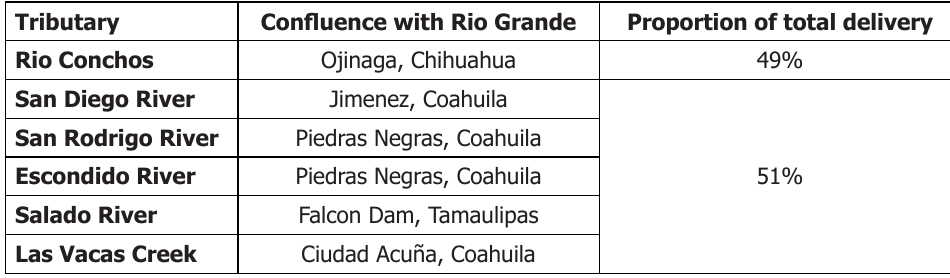
Table 1. Mexican tributaries of the Rio Grande under the 1944 water